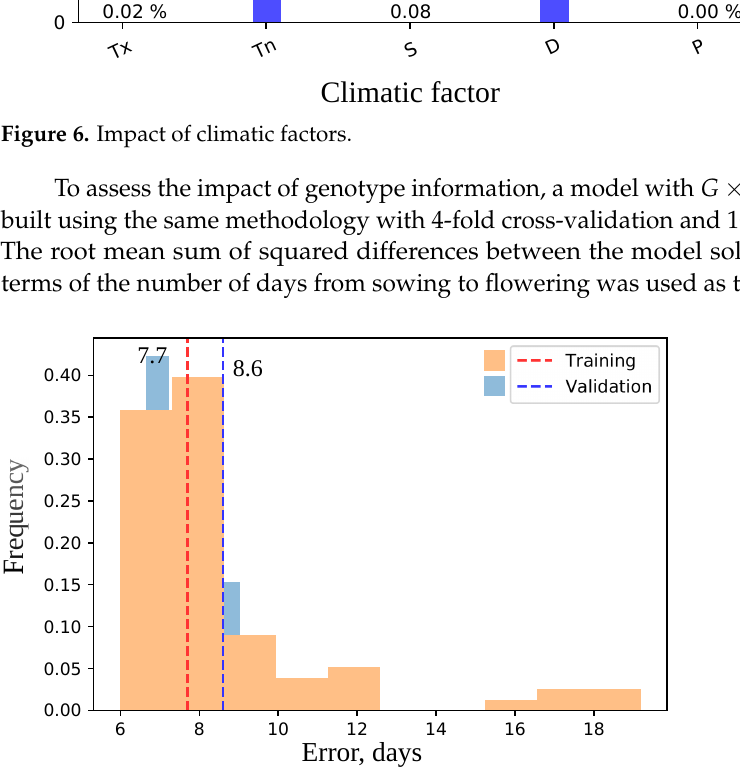
Figure 7. The histograms of root mean sum of squared differences between the model solution and data in terms of the number of days from sowing to flowering for training and validation sets for the model with genotype information (5). Vertical lines correspond to the